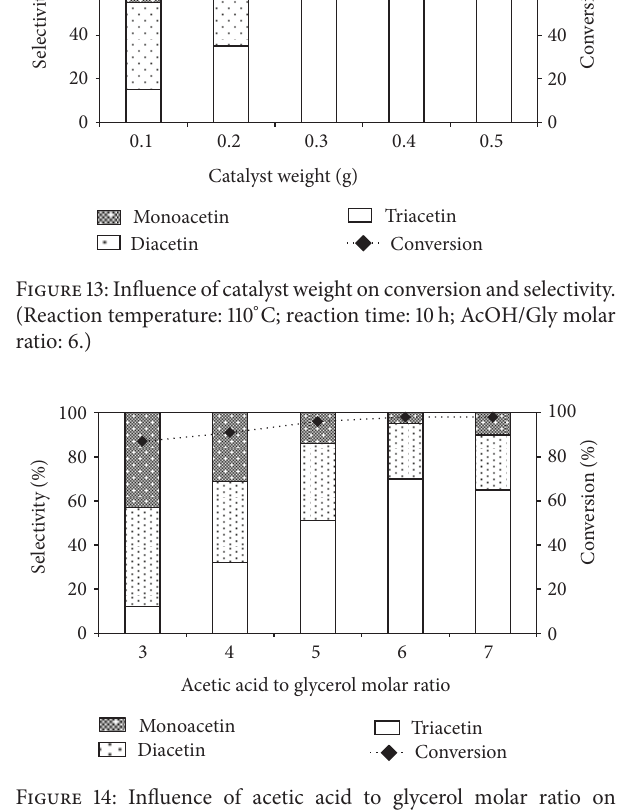
Figure 14: Influence of acetic acid to glycerol molar ratio on conversion and selectivity. (Reaction temperature: 110 ∘ C; reaction time: 10h; catalyst weight: 0.4